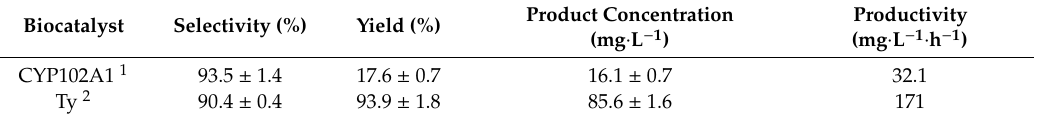
Table 1. Comparison of production abilities of engineered CYP102A1 and